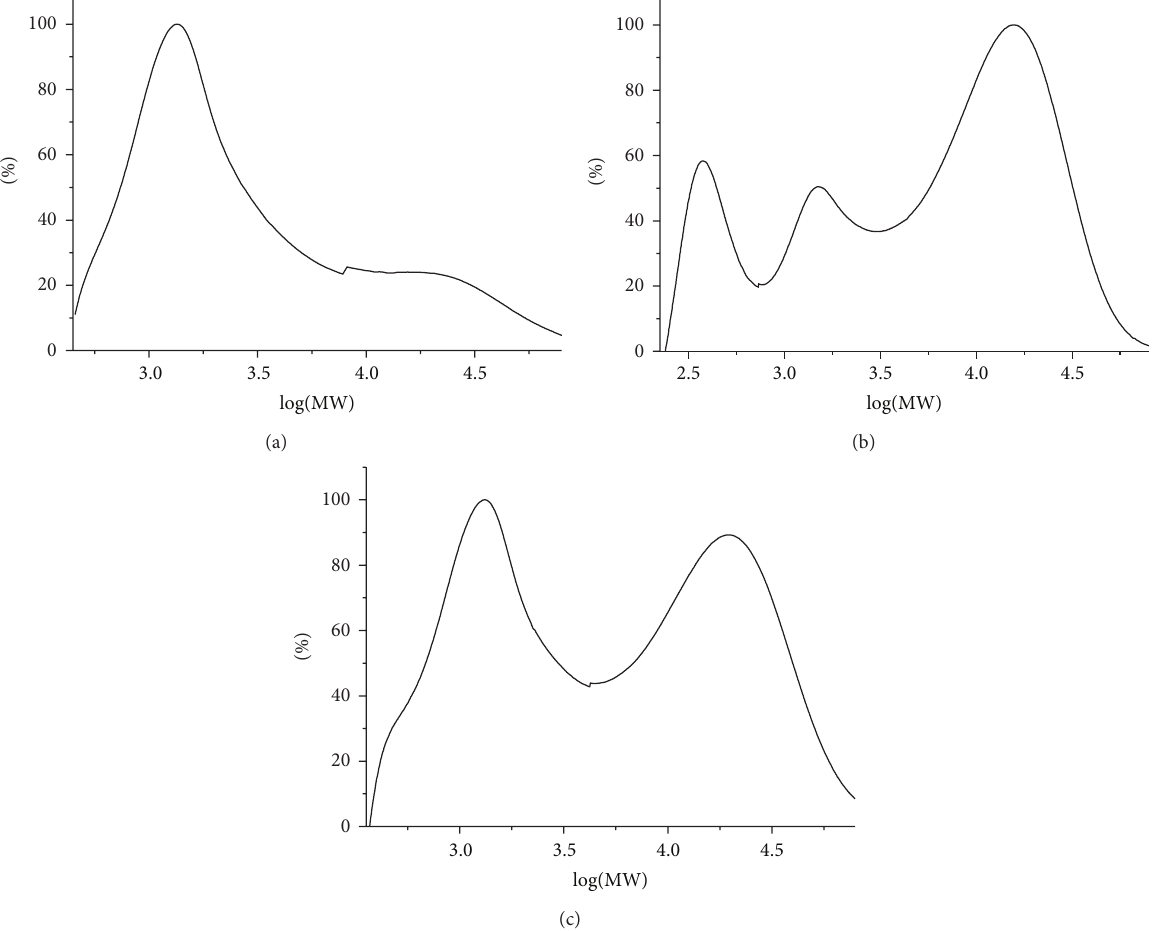
Figure 8: MWD curves calculated from GP chromatograms: (a)—sample 22 (control), (b)—sample 23 ([M]/[HEMA] = 20 mol. ratio), (c)— sample 24 ([M]/[HEMA] = 40mol. ratio); for details, see Table